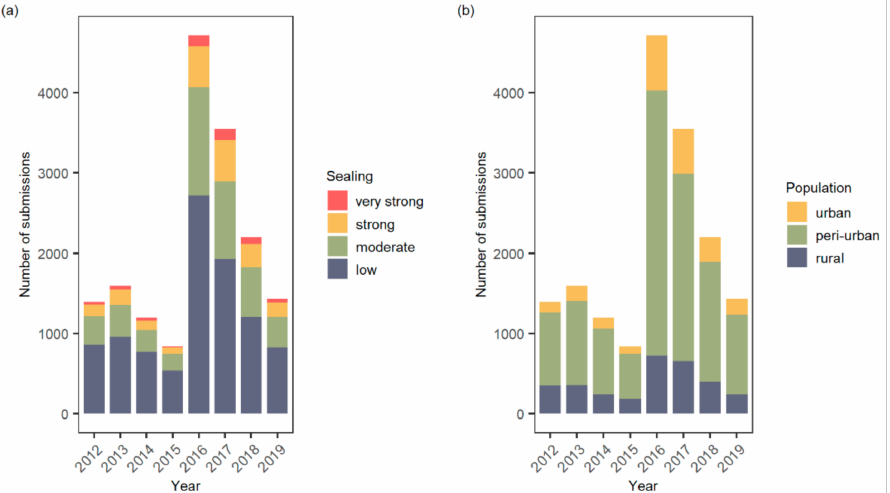
Figure 1. Numbers of submissions by year and level of urbanization, the latter assessed by ( a ) soil sealing and ( b ) human population density